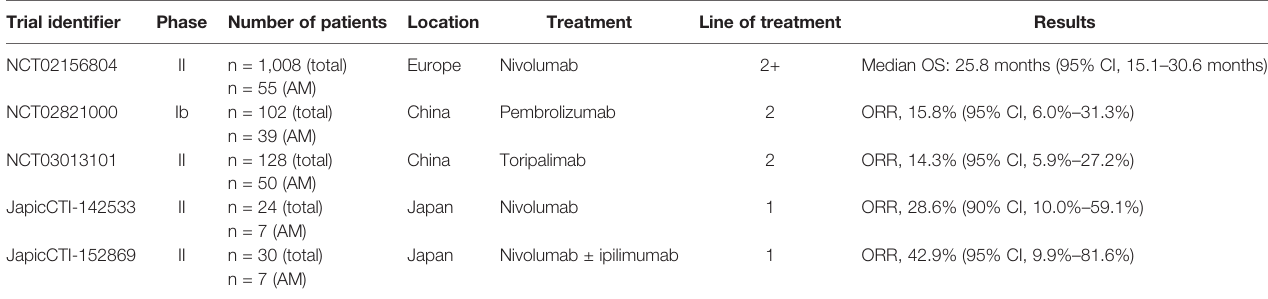
TABLE 1 | Summary of immunotherapy clinical trials involving sub-analysis of patients with acral melanoma. Trial identi fi